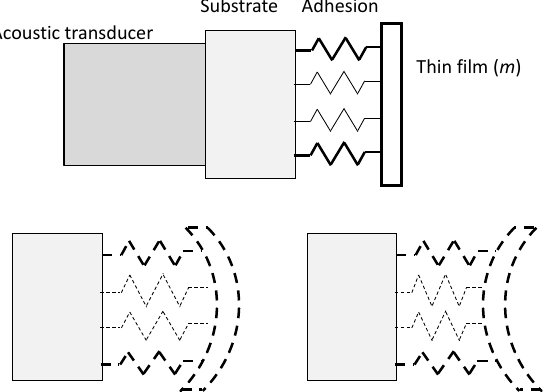
Figure 1. Physical model of thin-film systems. The figures at the bottom show the membrane-like vibration of the film surface due to the weaker elastic constant of the middle